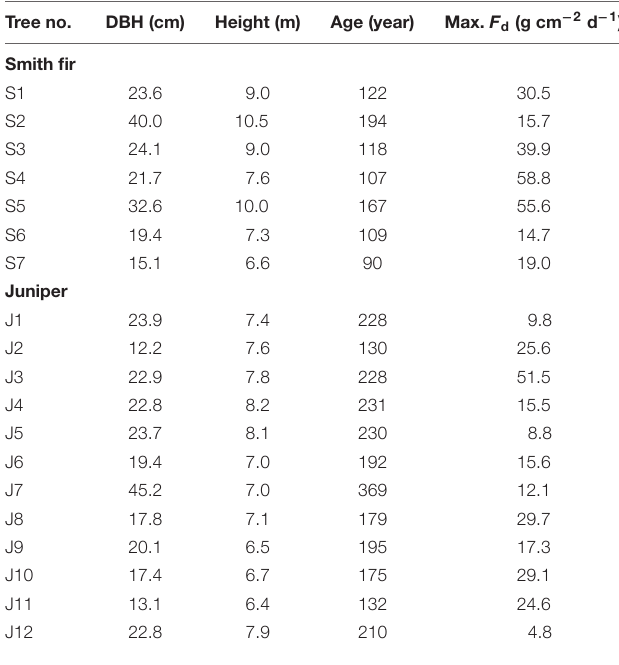
TABLE 1 | Diameter at breast height (DBH), tree height, tree age, and maximum daily sap flow (Max. F d ) observed during the monitoring period of 2012. Tree